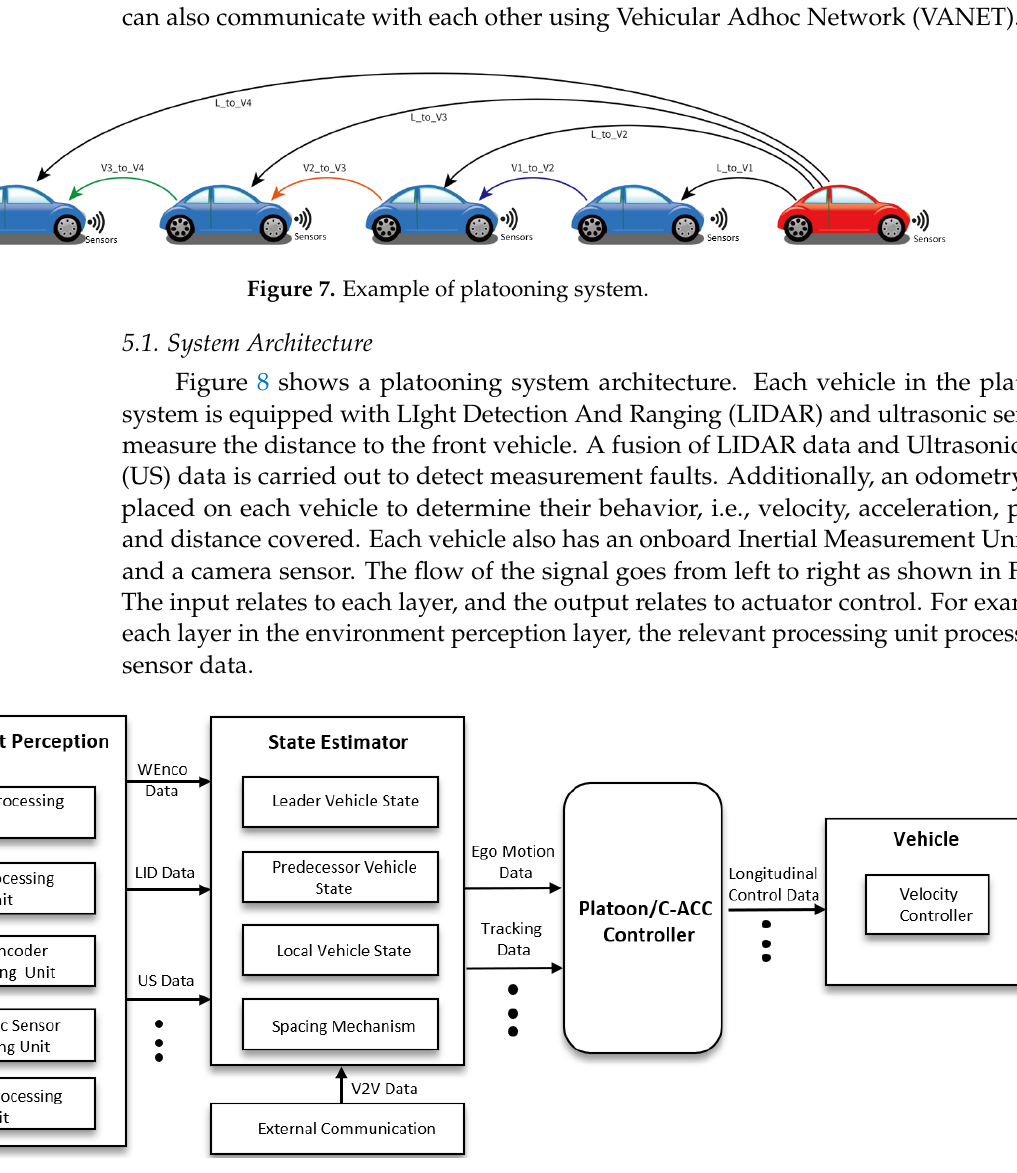
Figure 8. Platooning system architecture.